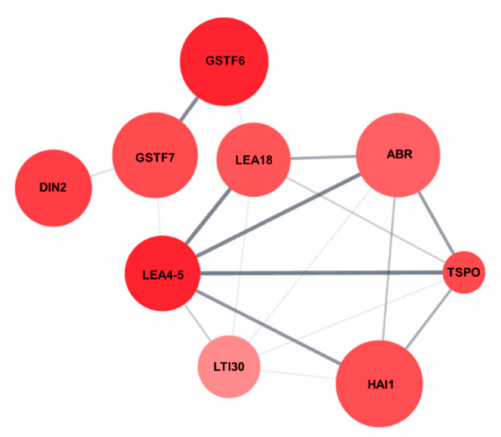
Figure 8. Protein network of the nine salt stress-responsive genes. Protein network interaction of the nine salt stress-responsive genes were analyzed using String Apps of